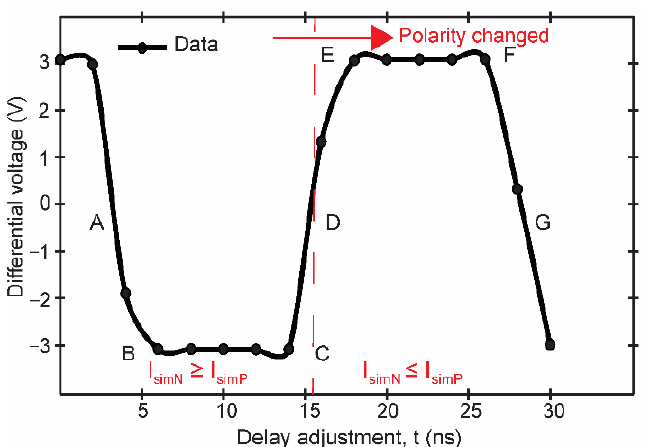
Figure 7. Points D, E, F, and G repeat similar behavior but in different polarities. Points A, D, and G are where both currents I ip and I in are at the same value; therefore, no differential voltage output is produced. The simulation result shows that the difference between two light intensities can be extracted, indicating the designed lock-in amplifier can be applied to SRS signal extraction.